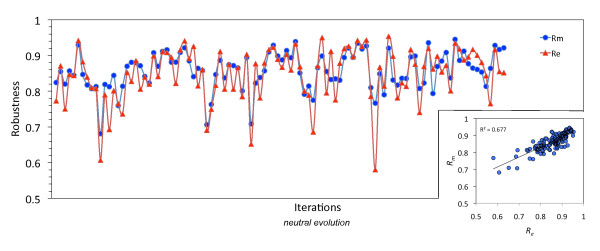
Congruent evolution of mutational and environmental robustness. Computation of mutational and environmental robustness (Rm and Re) during a neutral evolution (acceptance of mutations that do not change the structure) of a MicA-like sncRNA (scatter plot in the inset). These two trajectories show a pattern of congruent evolution. One iteration corresponds to 100 mutations (order O(L)).